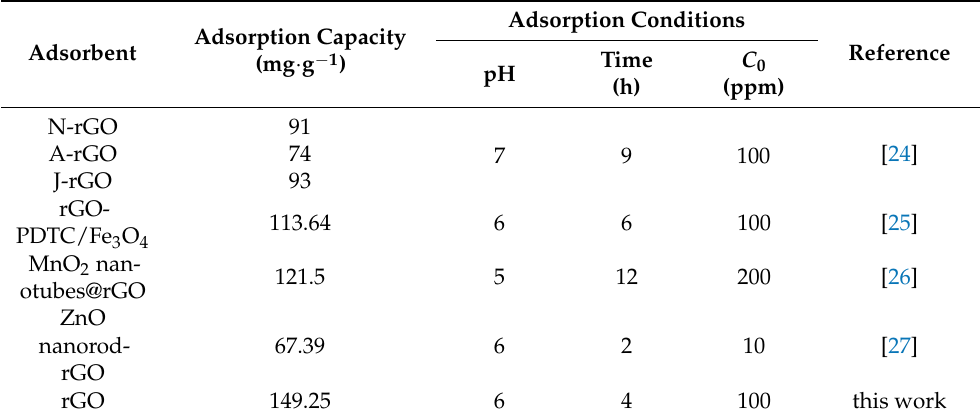
Figure 4. Effect of contact time for ( a ) Cu 2+ adsorption onto the rGO membrane ( b ) with four different concentrations. Table 2. Comparison of Cu 2+ adsorption of rGO with other adsorbents.